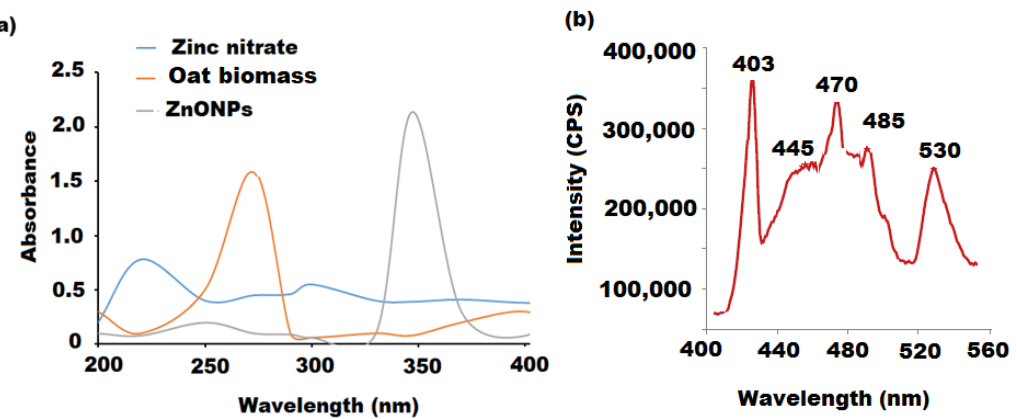
Figure 1. ( a ) UV-Vis spectra of green synthesized ZnONPs using oat biomass. The recorded spectra screened in the wavelength range 200–400 nm. ( b ) Photoluminescence spectrum of green synthesized ZnONPs using oat biomass.